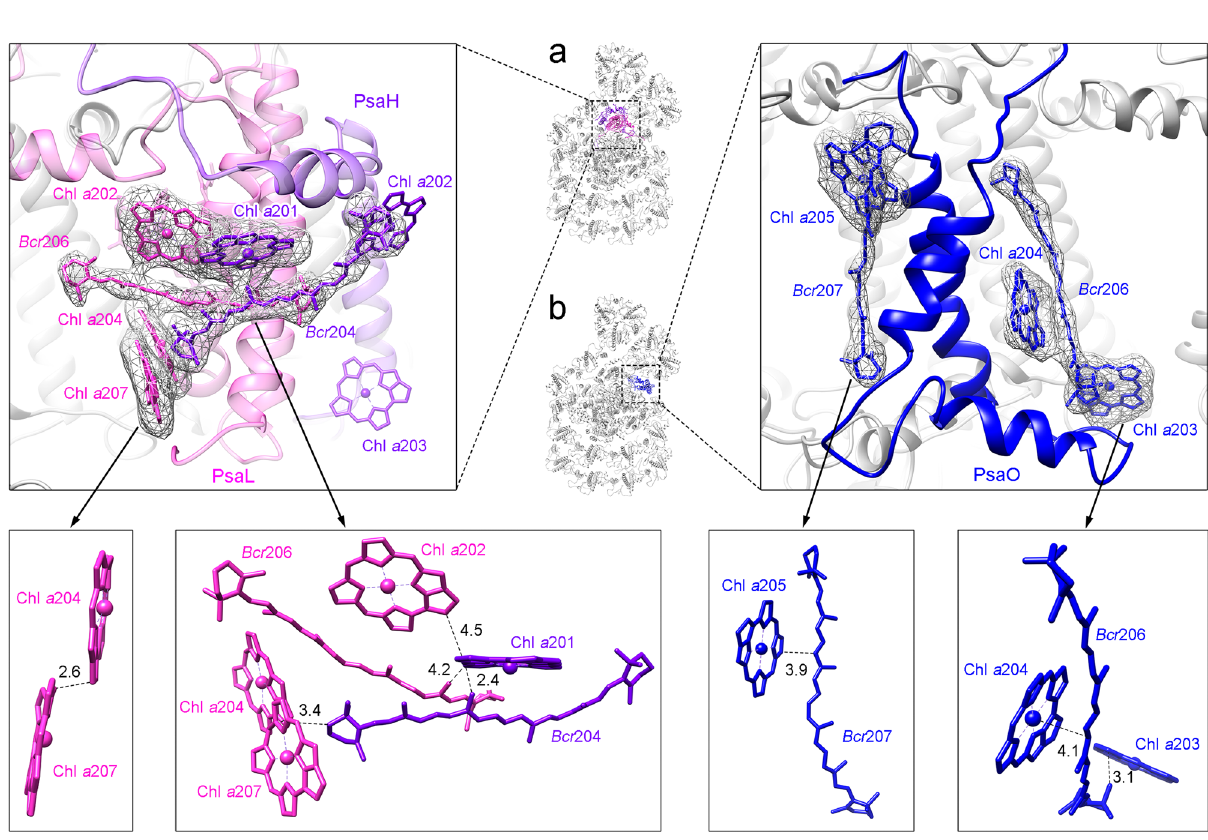
Fig. 8 Distribution pattern of typical chlorophylls and β -carotenes involved in excitation energy transfer from LHCII to the PSI core or photoprotection triggered by highlight. a, b Typical chlorophylls and β -carotenes around PsaH/PsaL (a) and PsaO (b) . Chlorophylls and β -carotenes involved in the possible EETs or photoprotection are highlighted as sticks and labeled with the same color as that of the protein subunits. The nearest distances (Å) between two adjacent pigments are indicated in